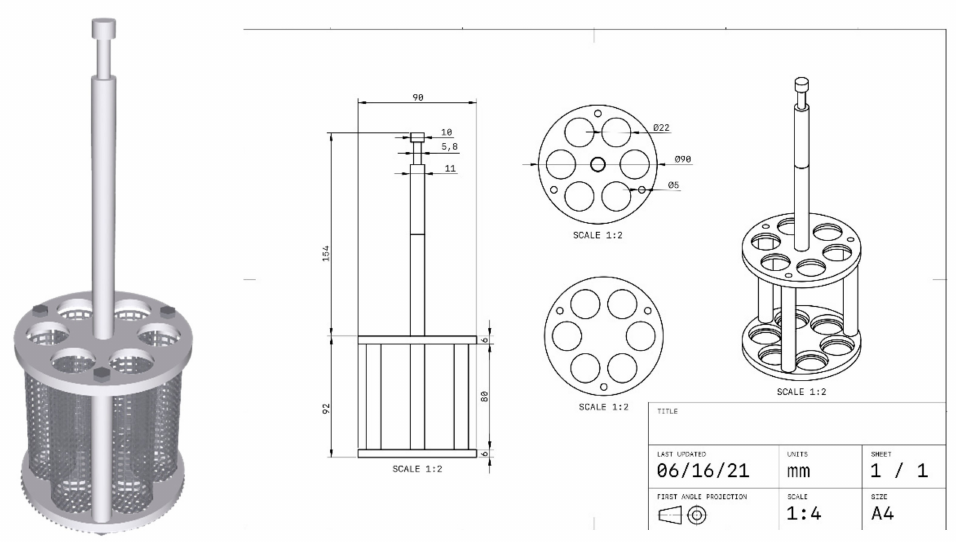
Figure 12. Modified tablet disintegration